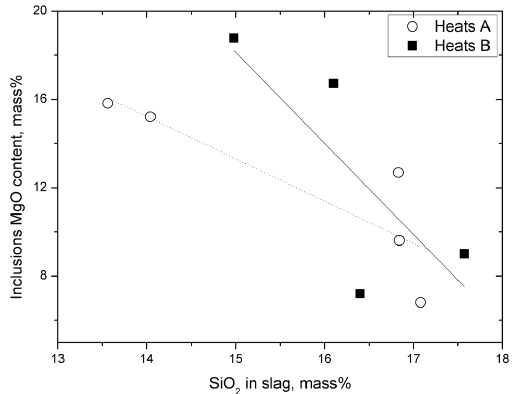
contents in slag on MgO content in 2